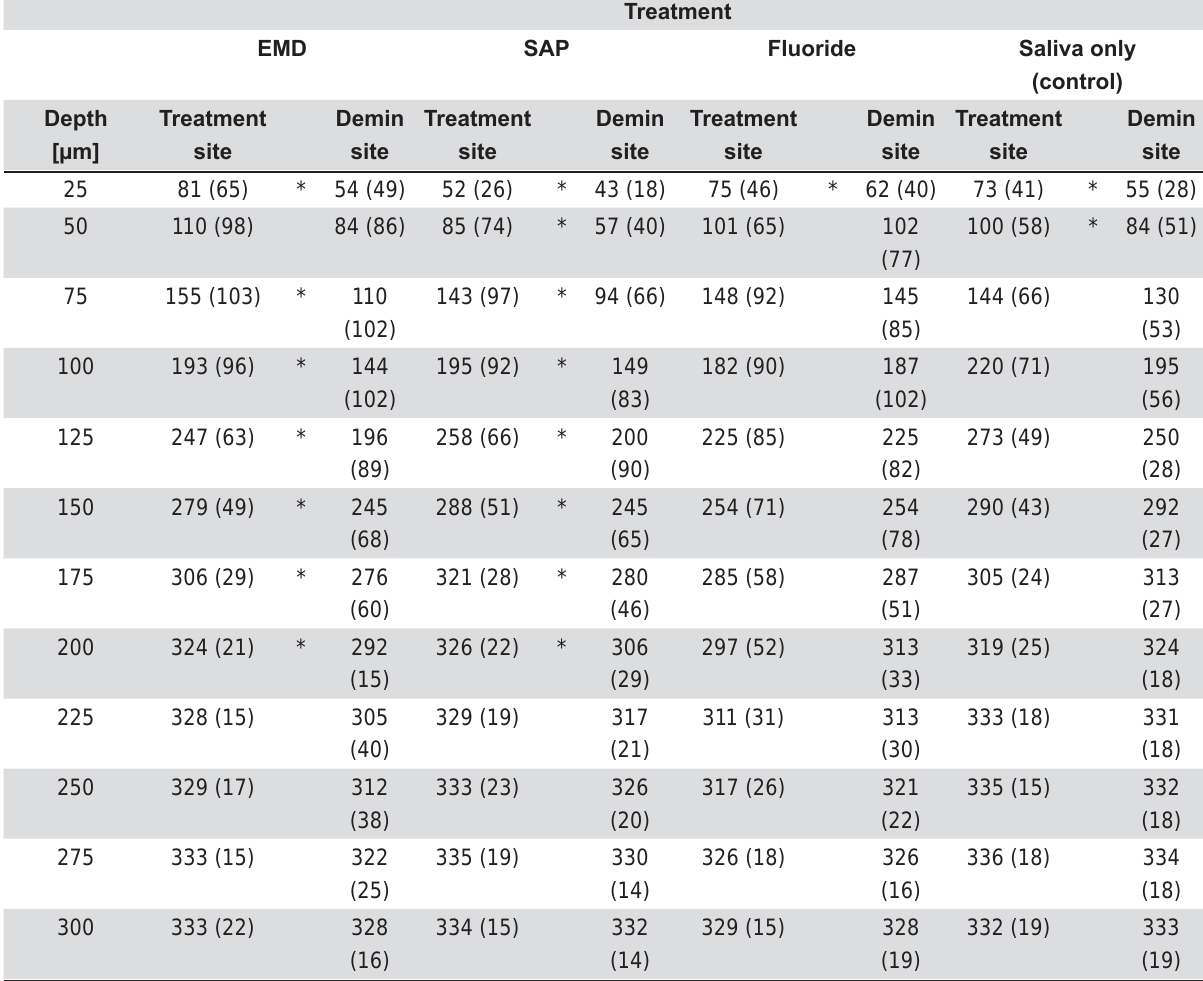
Table 1- Mean (SD) Subsurface microhardness (KHN) values after treatment (treatment site) with the respective products (EMD, SAP, Fluoride, and saliva only) at the different depth levels after demineralization as compared to the demineralization (cid:11)(cid:71)(cid:72)(cid:80)(cid:76)(cid:81)(cid:12)(cid:3)(cid:86)(cid:76)(cid:87)(cid:72)(cid:86)(cid:3)(cid:90)(cid:76)(cid:87)(cid:75)(cid:82)(cid:88)(cid:87)(cid:3)(cid:85)(cid:72)(cid:86)(cid:83)(cid:72)(cid:70)(cid:87)(cid:76)(cid:89)(cid:72)(cid:3)(cid:87)(cid:85)(cid:72)(cid:68)(cid:87)(cid:80)(cid:72)(cid:81)(cid:87)(cid:17)(cid:3)(cid:54)(cid:76)(cid:74)(cid:81)(cid:76)(cid:191)(cid:70)(cid:68)(cid:81)(cid:87)(cid:3)(cid:71)(cid:76)(cid:73)(cid:73)(cid:72)(cid:85)(cid:72)(cid:81)(cid:70)(cid:72)(cid:86)(cid:3)(cid:76)(cid:81)(cid:3)(cid:87)(cid:75)(cid:72)(cid:3)(cid:46)(cid:43)(cid:49)(cid:3)(cid:89)(cid:68)(cid:79)(cid:88)(cid:72)(cid:86)(cid:3)(cid:69)(cid:72)(cid:87)(cid:90)(cid:72)(cid:72)(cid:81)(cid:3)(cid:87)(cid:85)(cid:72)(cid:68)(cid:87)(cid:80)(cid:72)(cid:81)(cid:87)(cid:3)(cid:68)(cid:81)(cid:71)(cid:3)(cid:71)(cid:72)(cid:80)(cid:76)(cid:81)(cid:3)(cid:86)(cid:76)(cid:87)(cid:72)(cid:86)(cid:3) are marked with an asterisk (read